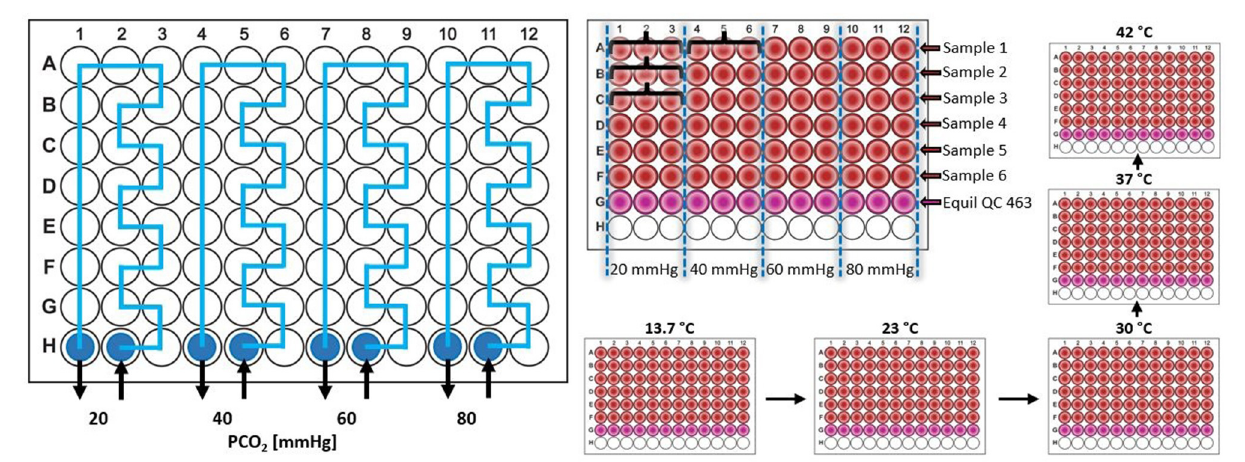
FIGURE 1 | Scheme of the four channel Oxygen Dissociation Curve (ODC) plate [see (17) for further descriptions of plate design and the measurement principles]. The gas supply was randomized throughout the study, here exemplary shown for increasing PCO 2 levels from left to right. Participant’s blood samples were pipetted in rows (e.g., participant 1 in row A, participant 2 in row B, …) and triplet measurement were obtained for all combinations (e.g., for participant 1: 3 ODC measurements in wells A1, A2, and A3 for the combination of gas system 20 mmHg and applied temperature X, 3 ODC measurements in wells A4, A5, and A6 for the combination of gas system 40 mmHg and applied temperature X, …, indicated by the curly brackets). Different temperature levels were achieved by heating between the experiments, thus temperature effect measured in consecutive experiments. PCO 2 , carbon dioxide partial pressure.